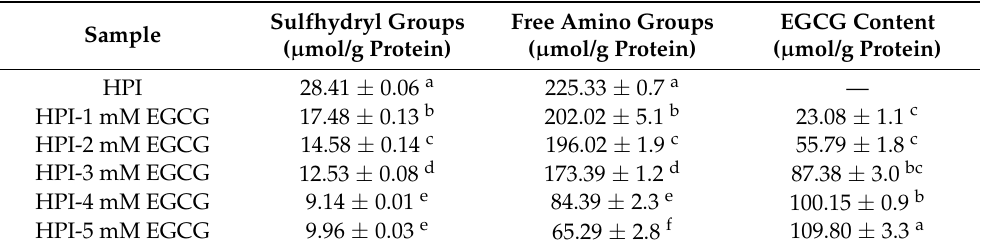
Table 1. The sulfhydryl group, free amino group, and EGCG concentrations in HPI-EGCG conjugates.